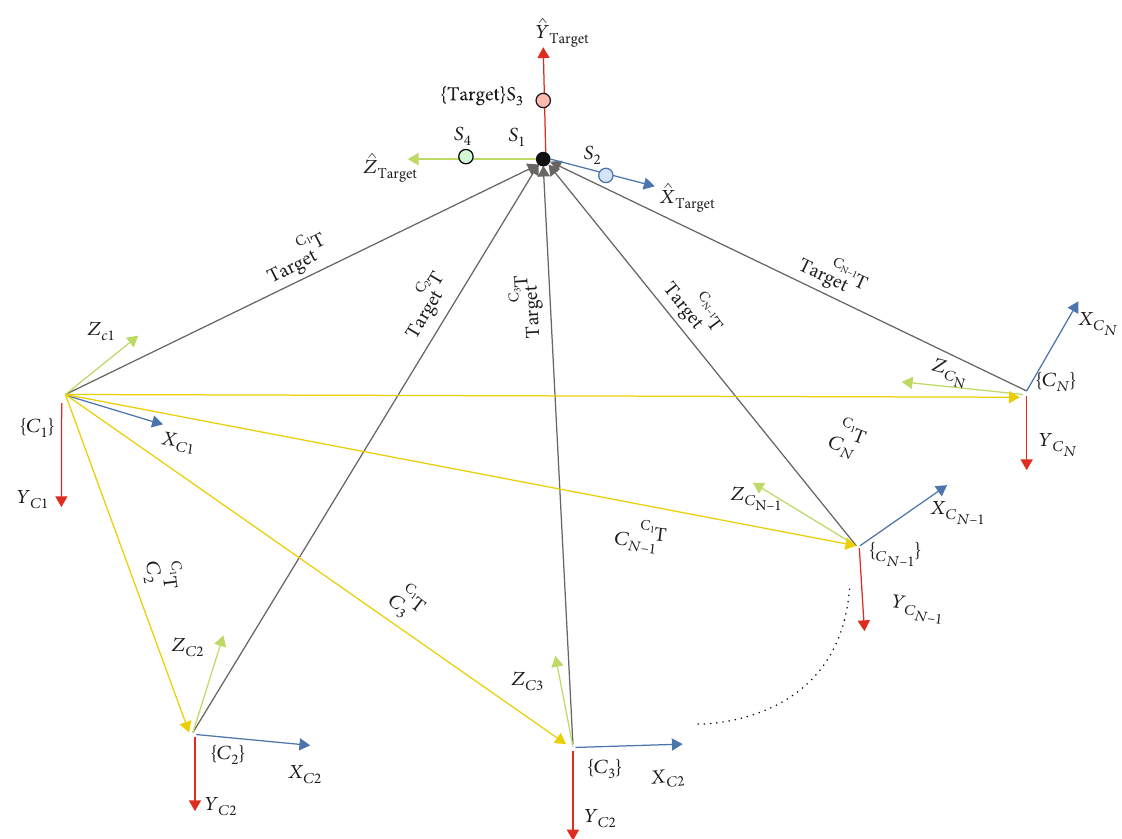
Figure 1: De fi nition of coordinate frame assignments and relative spatial descriptions of homogeneous frames in a network of multiple sensors. Here, arrows representing the relative descriptions between two frames (e.g., position and orientation of a frame that the head of the arrow is pointing with respect to the coordinate frame where the tail of the arrow is originating